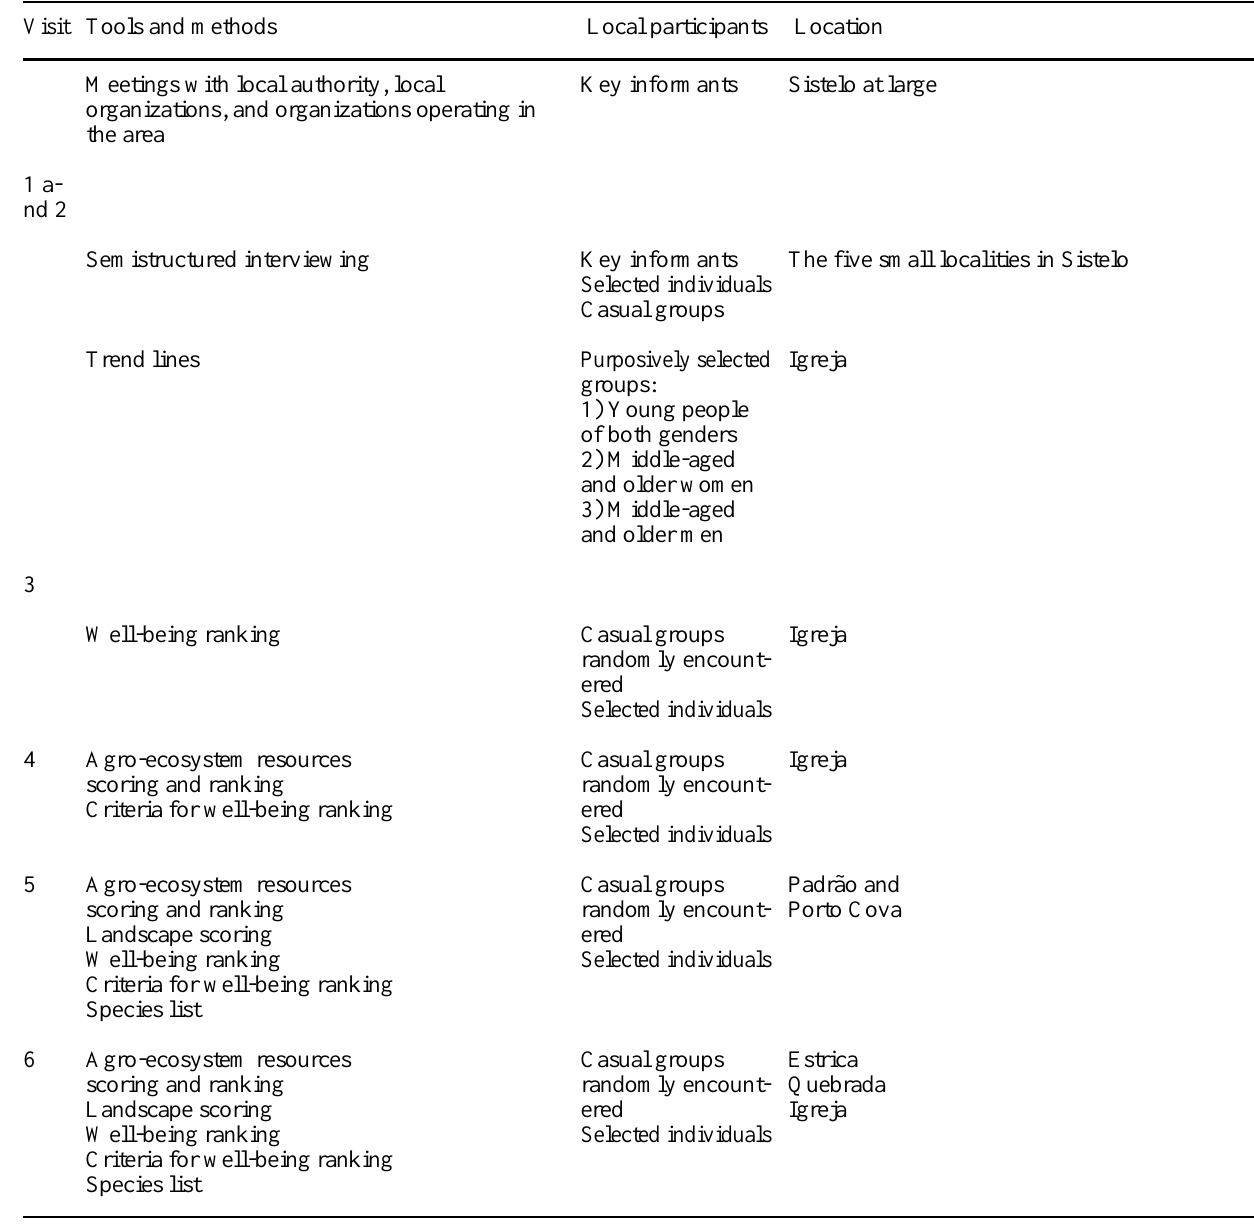
Table 2 . Organization of the fieldwork. Researchers also made direct observations and attempted to become familiar with and take part in community and daily activities during all the visits listed below. Visit Tools and